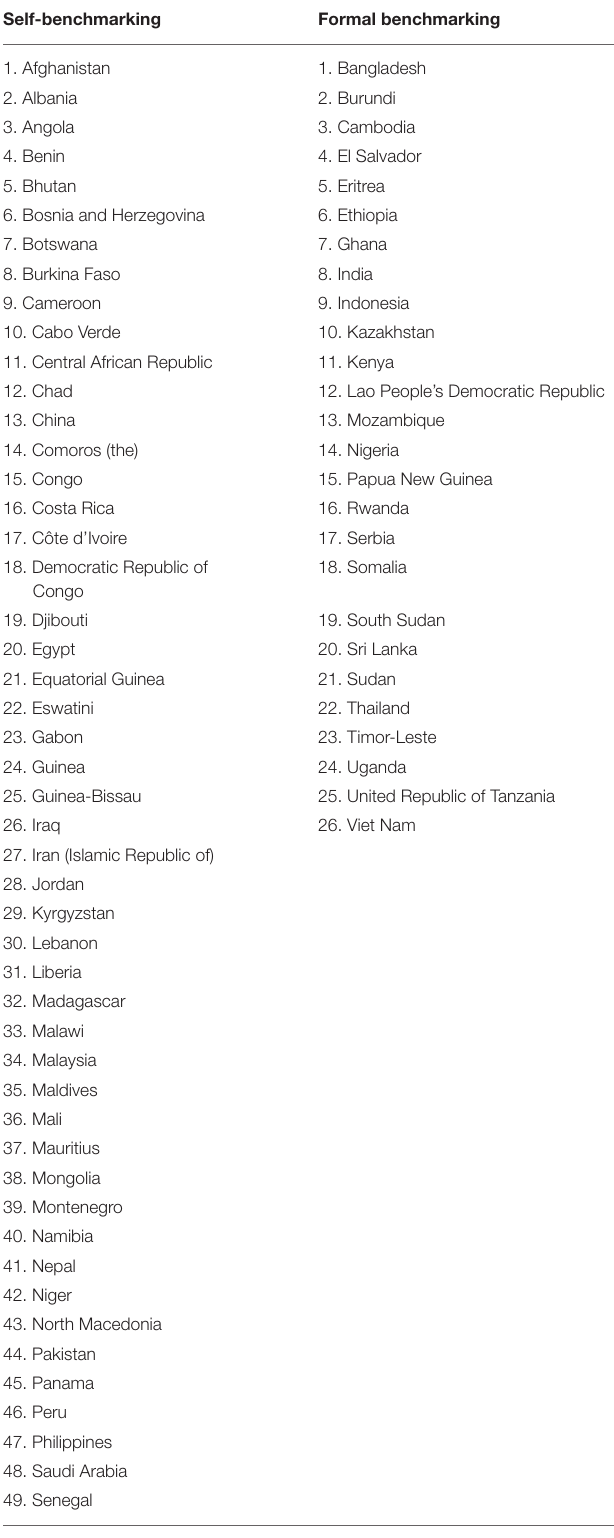
TABLE 2 | The 84 member states evaluated using the WHO’s global benchmarking tool between 2016 and 2020.